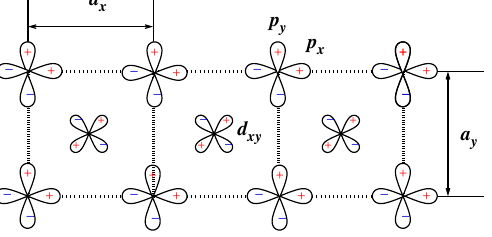
Figure 12. Basis of the five-band p − d model for a CuO 2